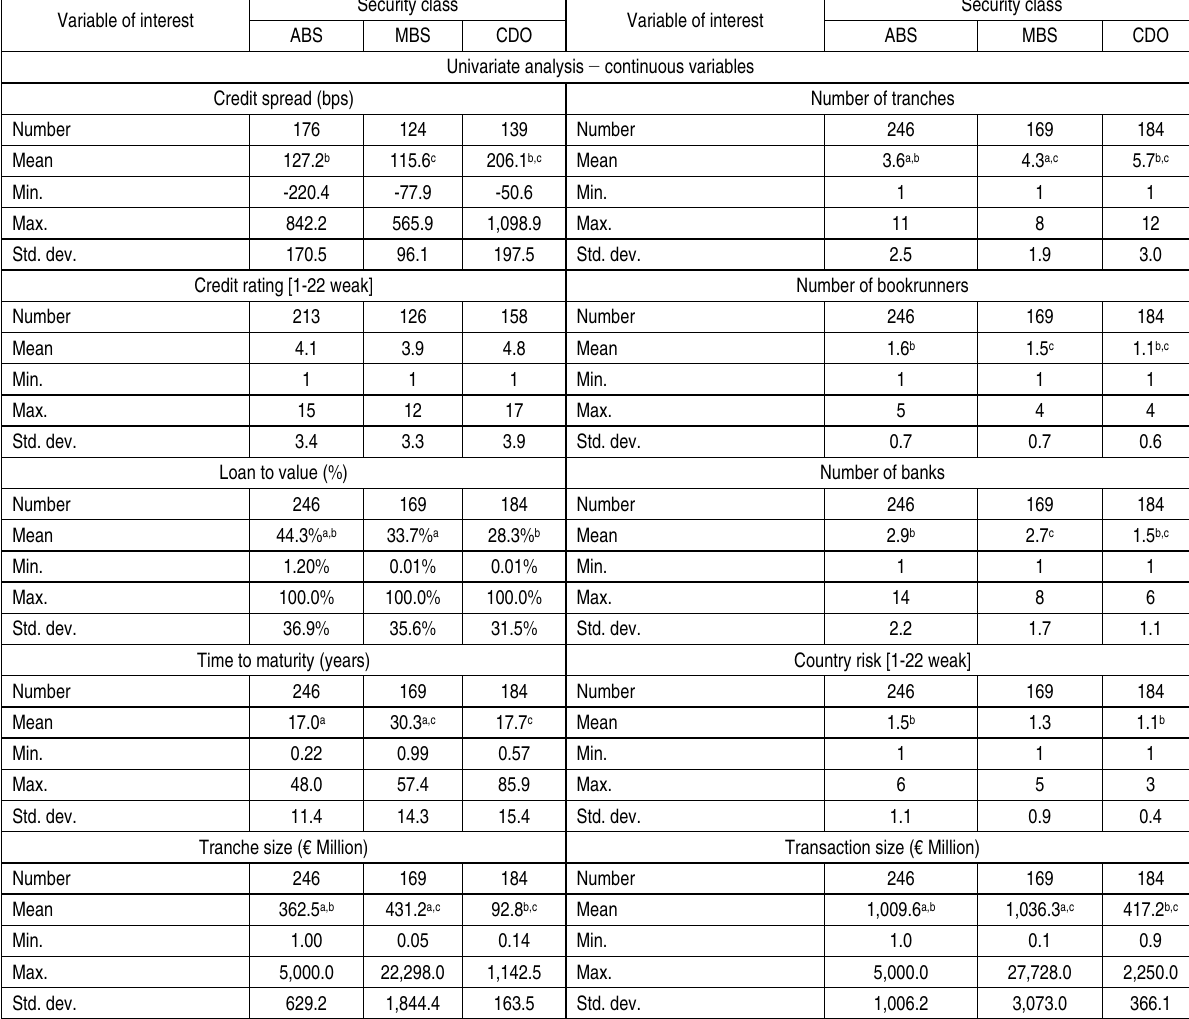
Table 4. Descriptive statistics for ABS, MBS and